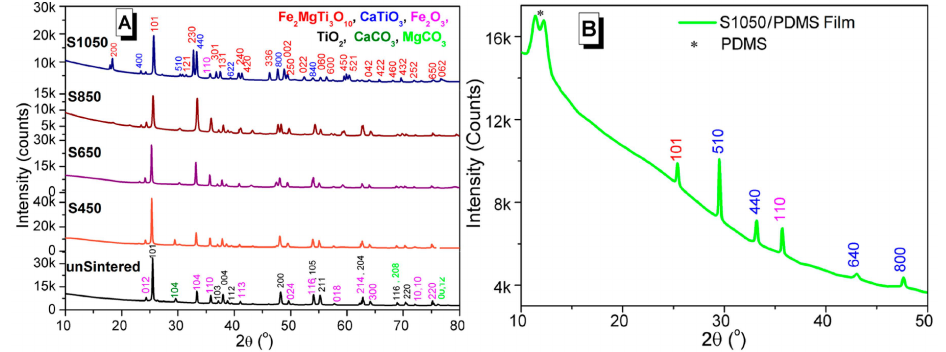
Figure 3. X-ray diffraction (XRD) (CuK α , λ = 1.54056 Å) patterns of the ( A ) ceramics samples unsintered (black-line); S450 (red-line); S650 (violet-line); S850 (brown-line); and S1050 (blue-line) and ( B ) S1050/polydimethylsiloxane (PDMS) composite film (light green-line). Note: the colors that denote the crystalline planes of corresponding materials are pink—Fe 2 O 3 , black—TiO 2 , green—CaCO 3 , red—Fe 2 MgTi 3 O 10 , brown—Fe 3 O 4 , and blue—CaTiO 3